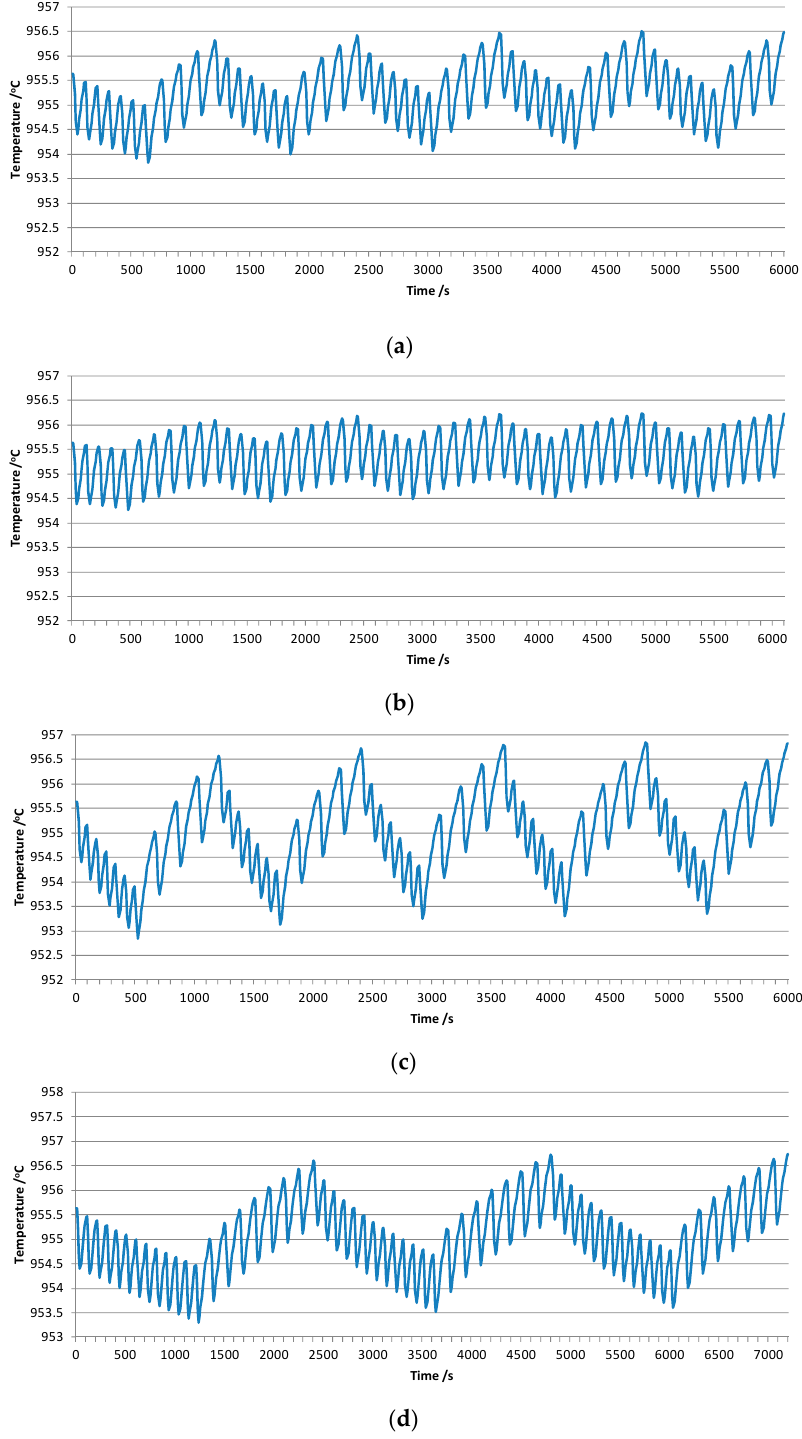
Figure 7. Temperature curves of Cases 1-4 under overfeeding followed by underfeeding. ( a ) Case 1 (OU), overfed (t = 100 s)–underfed (t=150 s); ( b ) Case 2 (OU), overfed (t = 110 s)–underfed (t=130 s); ( c ) Case 3 (OU), overfed (t = 80 s)–underfed (t = 180 s); ( d ) Case 4 (OU), overfed (t = 100 s)–underfed (t = 150 s).